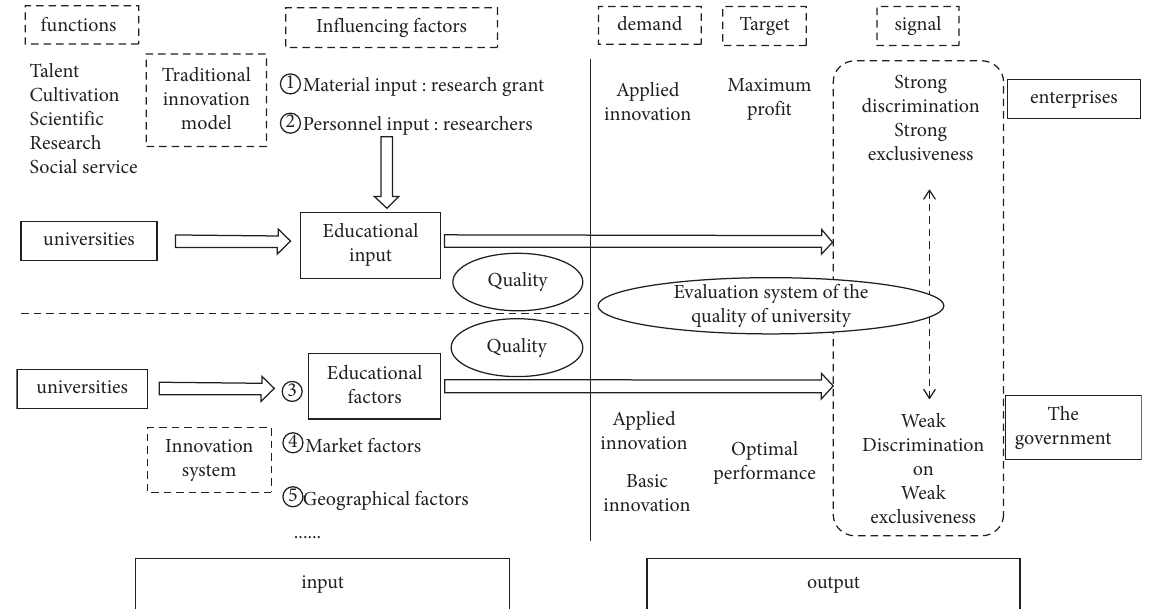
Figure 1: Theoretical